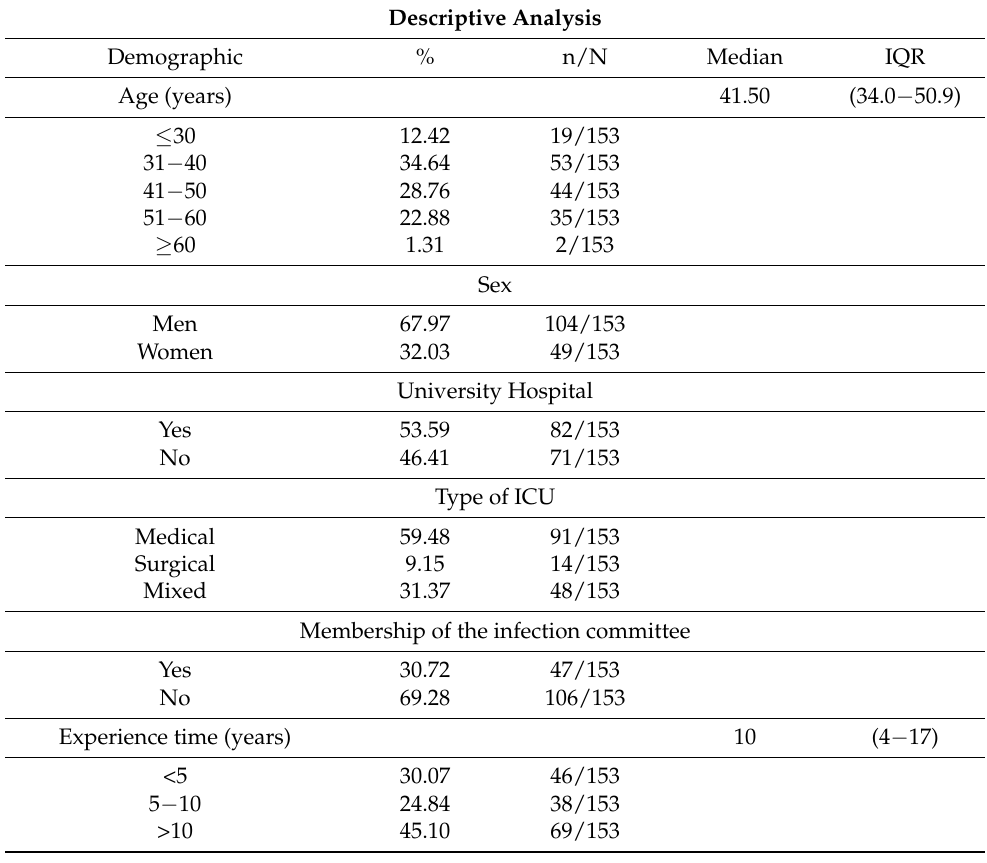
Table 1. Descriptive analysis of sociodemographic information and clinical